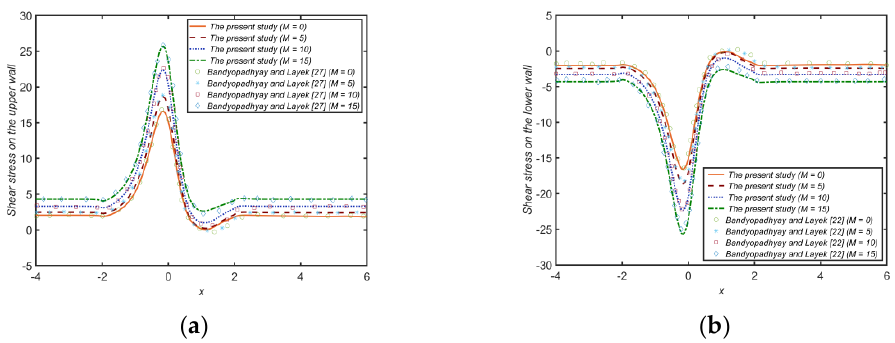
Figure 3. The WSS distribution on varying magnetic parameter values, ( a ) on the upper wall, and ( b ) on the lower wall.